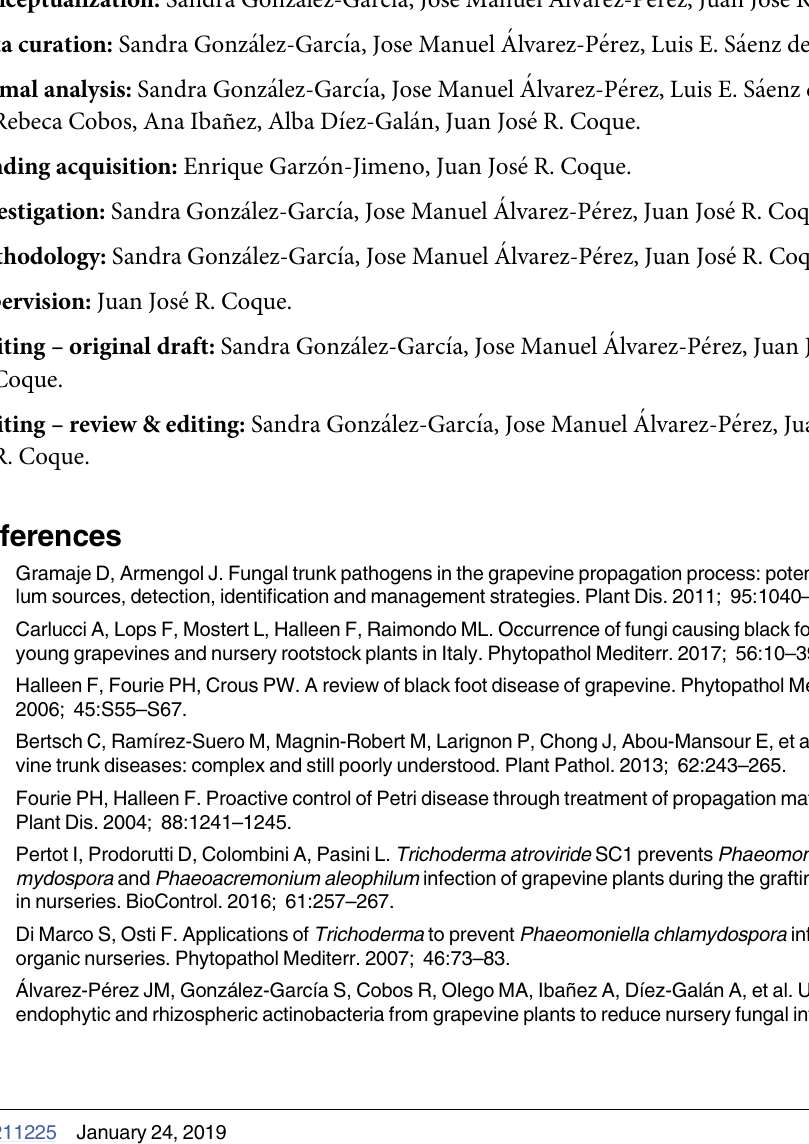
VV/R4. MW: GeneRuler 1kb DNA Ladder Plus (Thermo Fisher Scientific). NC (negative